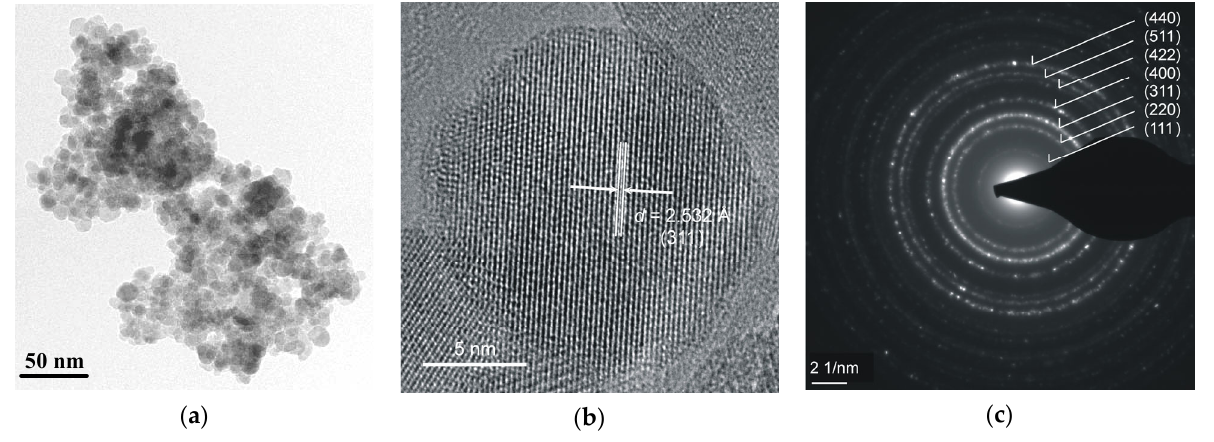
Figure 30. TEM ( a ) and HRTEM ( b ) images of the as‑prepared Fe 3 O 4 nanoparticles and SAED (selective area electron diffraction) pattern of the nanoparticles ( c ). Adapted from Ref. [70] with permission from Elsevier: Spectrochimica Acta, Part A: Molecular and Biomolecular Spectroscopy, Vol. 100, Oshtrakh M.I., Šepelák V., Rodriguez A.F.R., Semionkin V.A., Ushakov M.V., Santos J.G.,